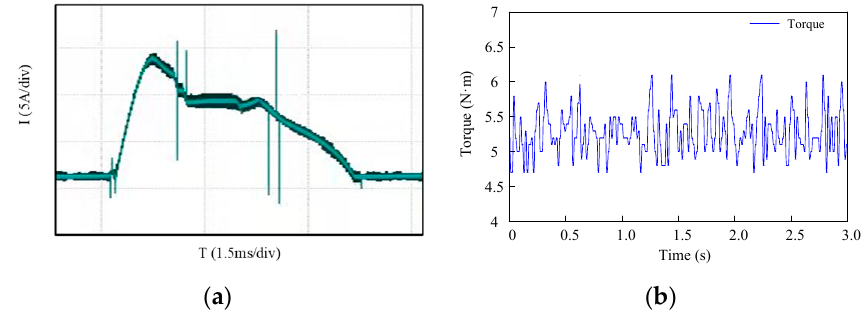
Figure 15. Waveforms of conventional TSF at 500 r/min: ( a ) current; ( b ) torque.